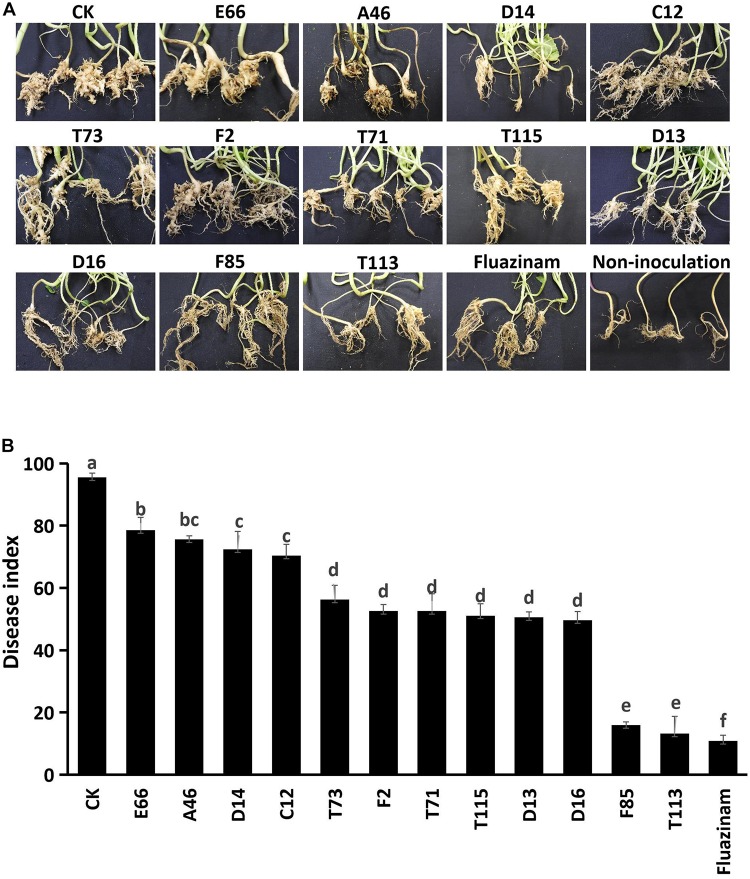
Control efficiency of the biocontrol bacterial strains against P. brassicae in greenhouse. (A) Morphology of rapeseed roots of each bacterial treatment. (B) Disease incidence of clubroot treated with bacterial suspensions. Each experiment was repeated three times. Different letters indicate significant differences between different treatments according to LSD test (P < 0.05). Capped lines represent standard errors.